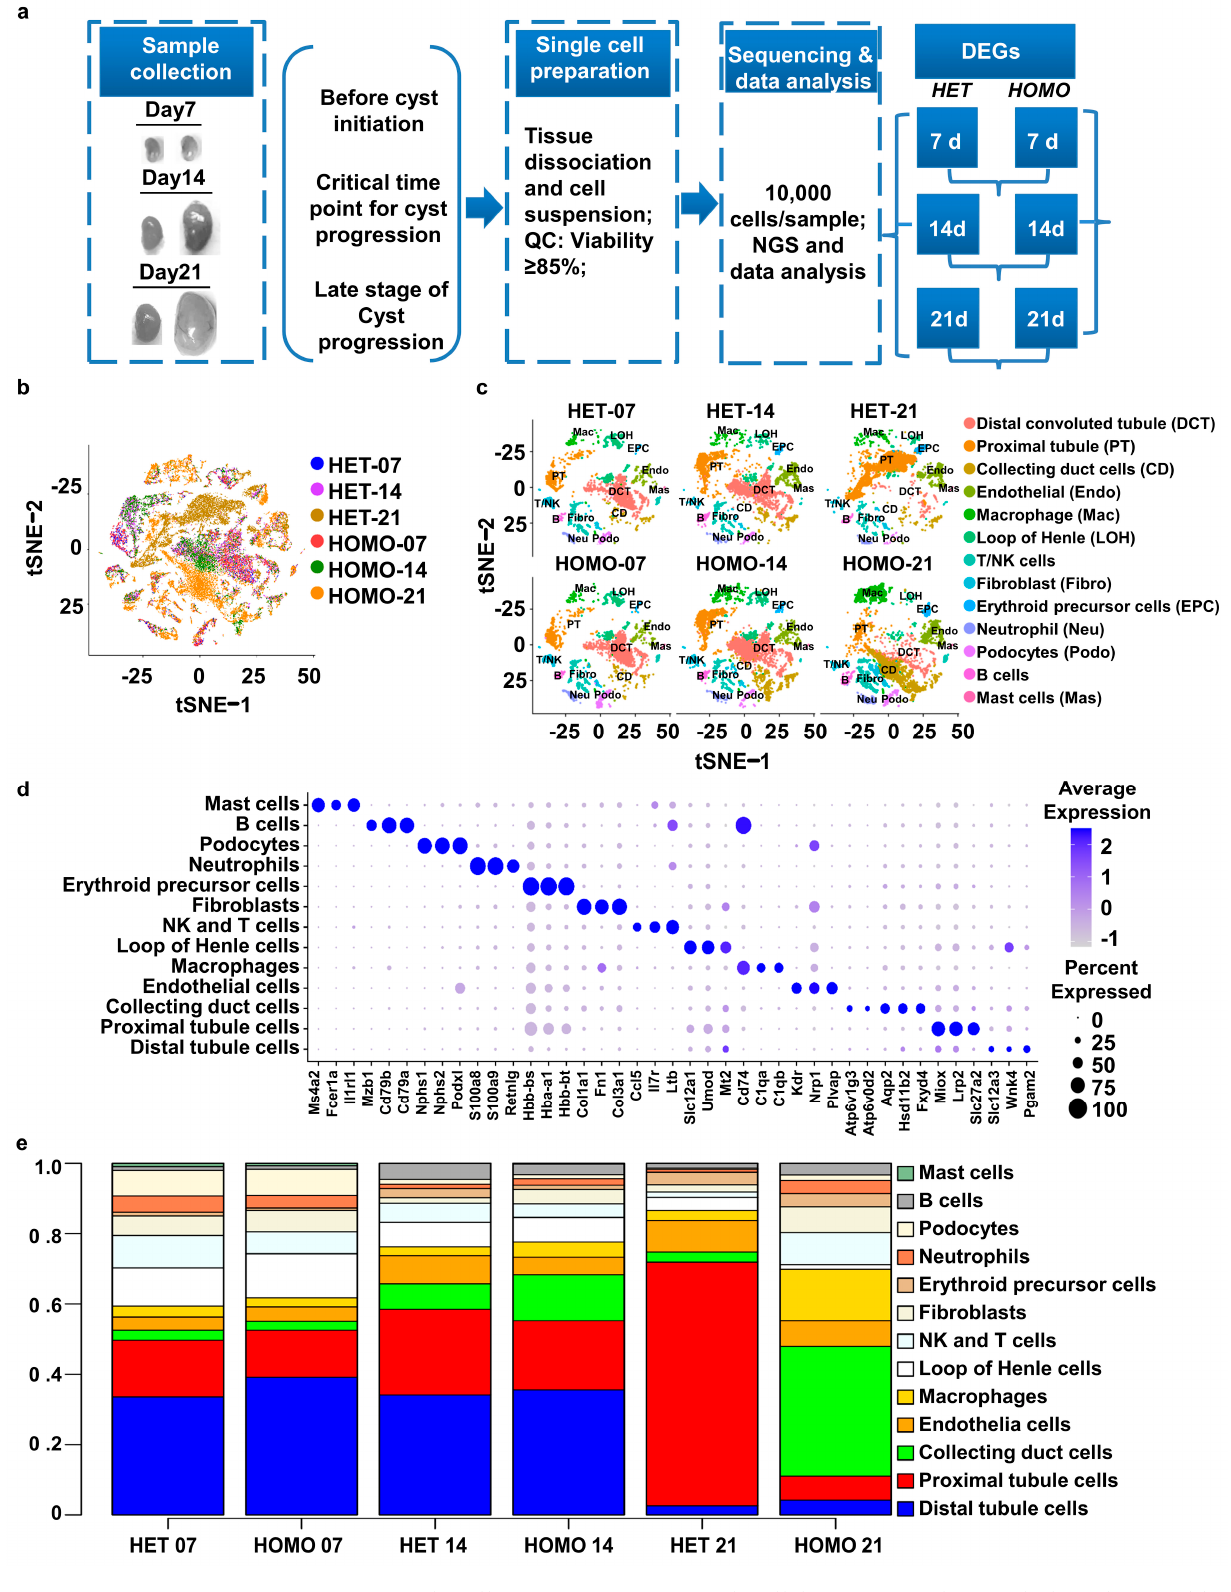
Figure 1. Single-cell RNA sequencing reveals cell diversity in polycystic kidney disease. ( a ) Work- flow showing the collection of mouse kidneys, including paired HET and HOMO kidneys of a Pkd1 mouse model. ( b ) tSNE plot showing cell distributions from six different kidney groups, including 3 Pkd1 heterozygous deletion mice ( Pkd1 HET-07/14/21) and 3 Pkd1 homozygous deletion mice (